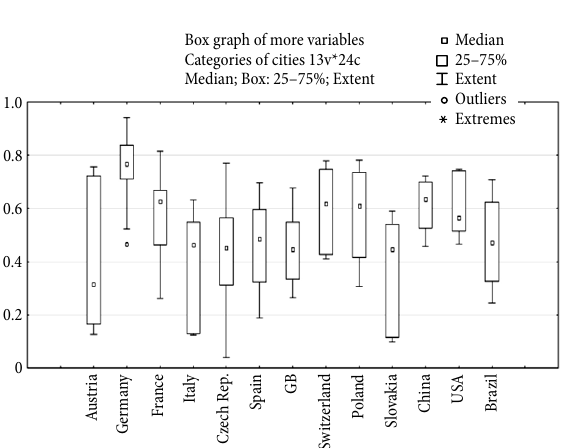
Fig. 6. Medians of UPT websites scores after countries